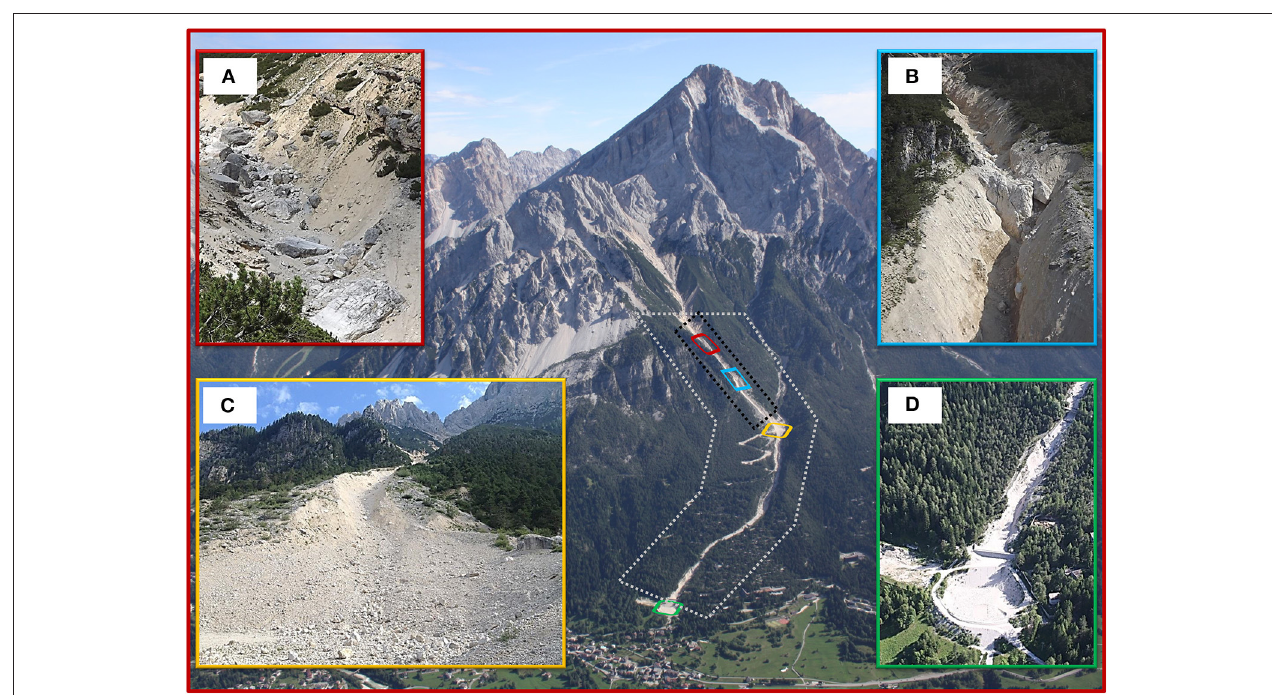
FIGURE 1 | Aerial view of the Rovina di Cancia study site. (A) Debris flow triggering area ( triggering area (